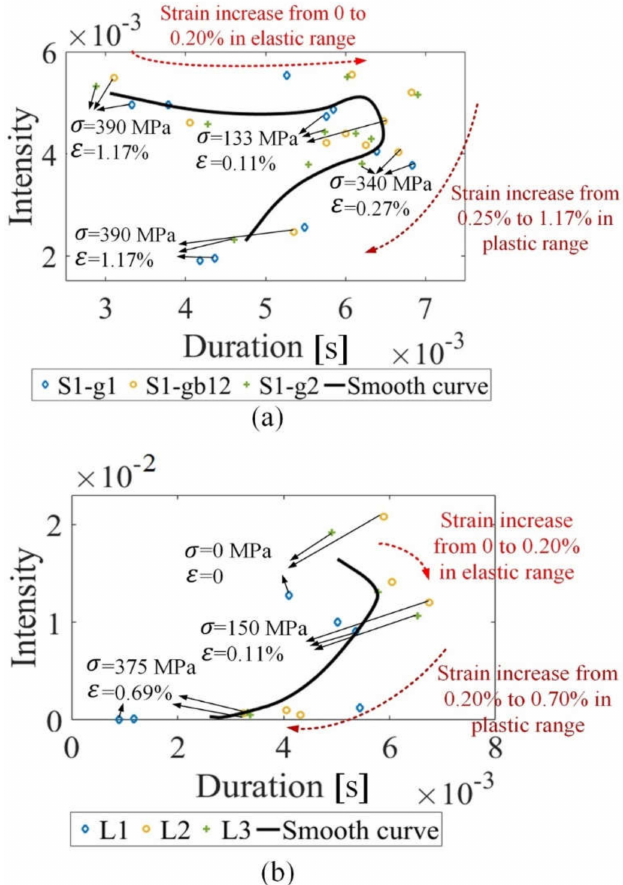
Figure 11. The eigenvalue fusion ( T σ , INT σ ) for stress measurement of sample 1 and sample 2: ( a ) shows the eigenvalue fusion of sample 1; ( b ) shows the eigenvalue fusion of sample